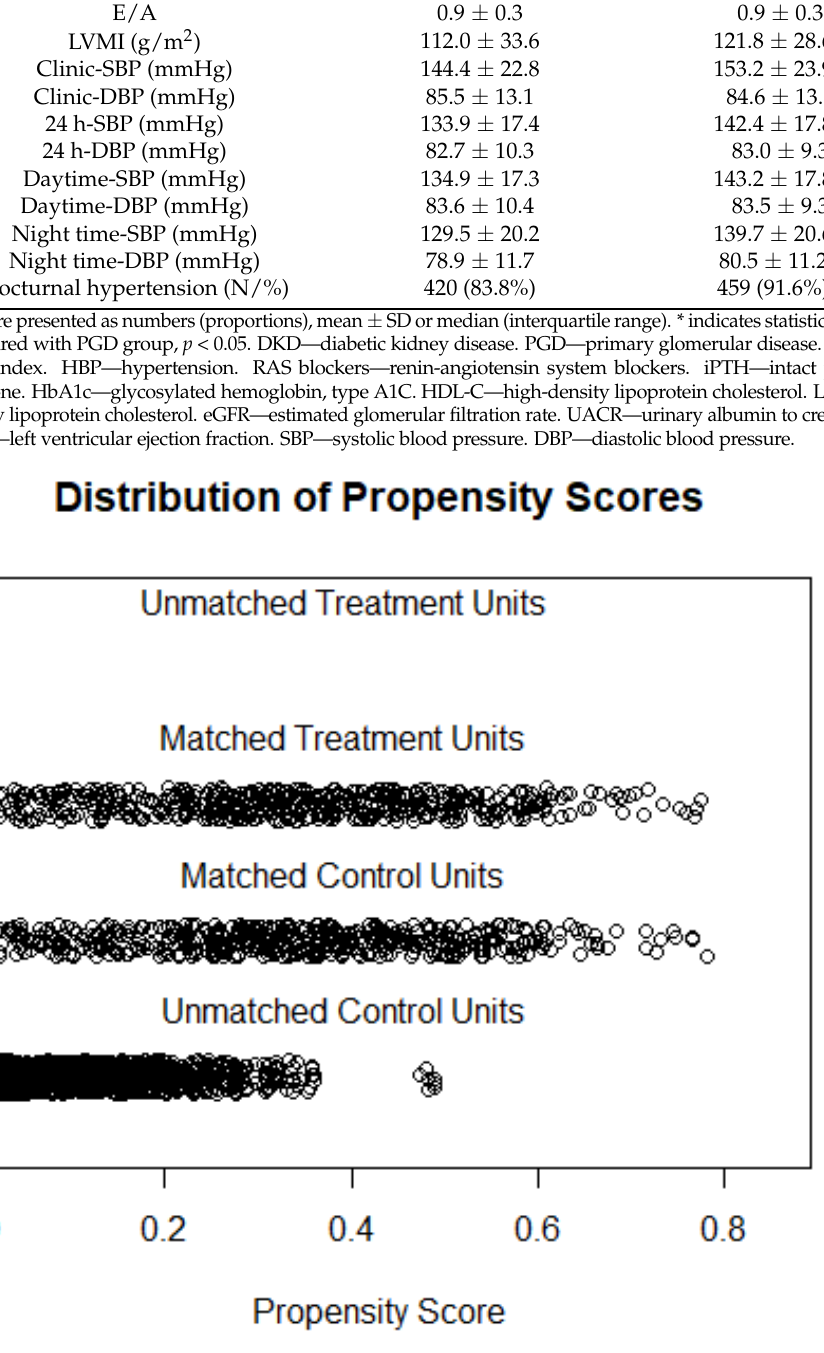
Patients in the DKD group compared with patients in the PGD group showed higher clinical systolic blood pressure (SBP), 24 h average SBP, daytime SBP and night-time BP ( p < 0.05) (Table 1). The prevalence of nocturnal hypertension in the DKD group was 91.6% which was higher than 83.8% in the PGD group (Table 1). There were 9 (1.8%) patients with extreme dipper pattern, 67 (13.4%) patients with normal dipper pattern, 245 (48.9%) patients with non-dipper pattern, and 180 (35.9%) pa- tients with reversed dipper pattern in the DKD group. There were 6 (1.2%) patients with extreme dipper pattern, 113 (22.6%) patients with normal dipper pattern, 247 (49.3%) pa- tients with non-dipper pattern, and 134 (26.7%) patients with reversed dipper pattern in the PGD group. Compared with the PGD group, the DKD group showed a higher preva- lence of reversed dipper pattern and lower normal dipper pattern ( p < 0.05). There were 51 (10.2%) patients with normotension and 330 (65.9%) patients with sus- tained hypertension in the DKD group. Misclassification was detected in 24% of DKD patients: 38 (7.6%) patients with white-coat hypertension and 82 (16.4%) patients with masked hypertension. There were 97 (19.4%) patients with normotension and 258 (51.5%) patients with sustained hypertension in the PGD group. Misclassification was detected in 29% of PGD patients: 45 (9.0%) patients with white-coat hypertension and 101 (20.2%) patients with masked hypertension. Compared with the PGD group, the DKD group